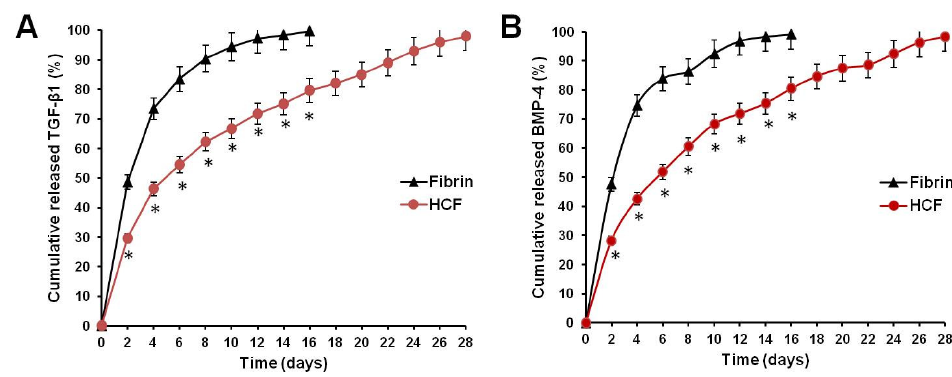
Figure 2. Profiles of cumulative release of TGF- β 1 ( A ) and BMP-4 ( B ) from fibrin and HCF hydrogels. The values represent mean ± standard deviation ( n = 6). * Significant difference from fibrin group, p ≤ 0.05.